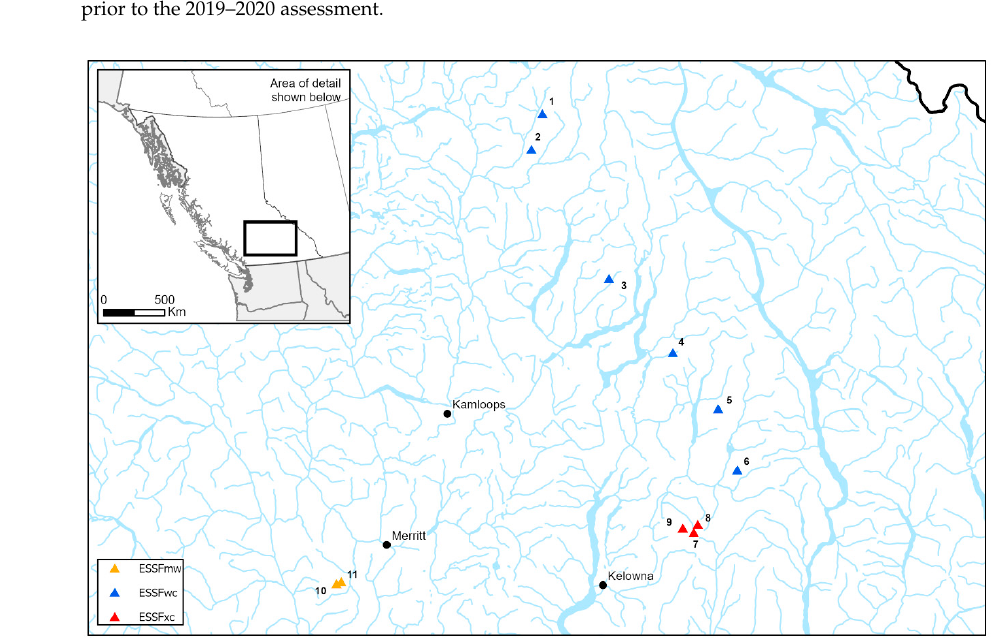
Figure 1. Geographic location of 11 permanent sample plots in southern British Columbia. Inset shows the geographic area in B.C. of the detailed map. Plots are: 1 = Raft River; 2 = Martin Creek; 3 = Scotch Creek; 4 = Sicamous Creek; 5 = Torrent Creek; 6 = Cherry Creek; 7 = Home Lake-1; 8 = Home Lake-2; 9 = Buck Mountain; 10 = Spius Creek-1; and 11 = Spius Creek-2.